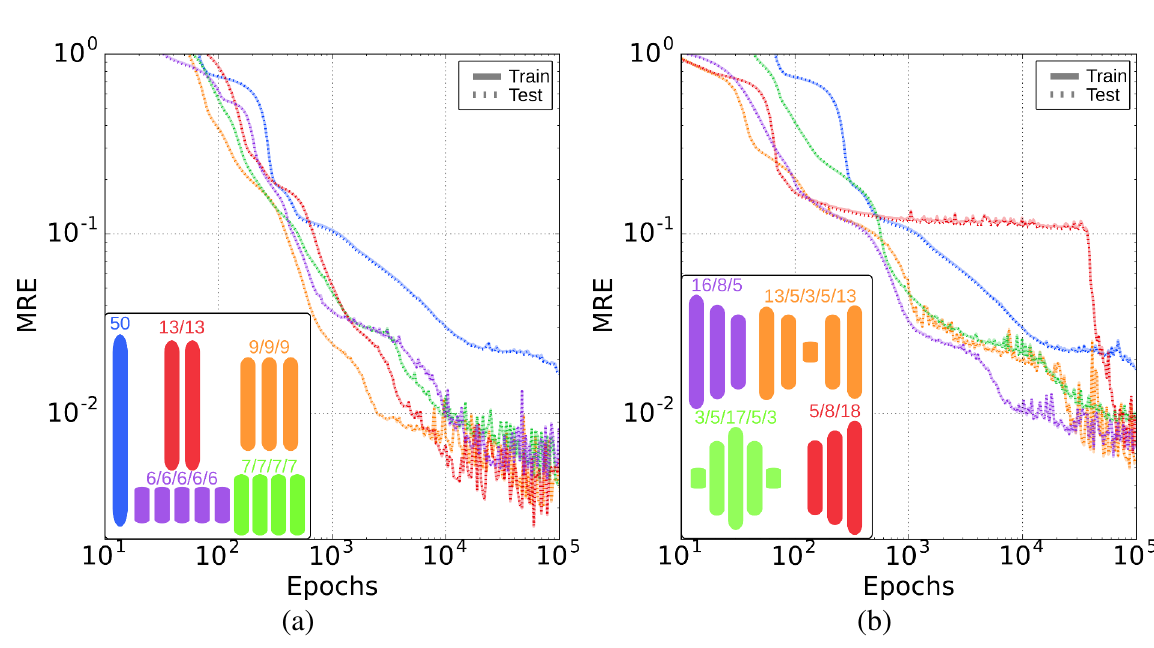
Figure 1: MRE for U 235 for ANN (a) constant number of neurons per layer (b) common f 2 architectures with varying neurons per